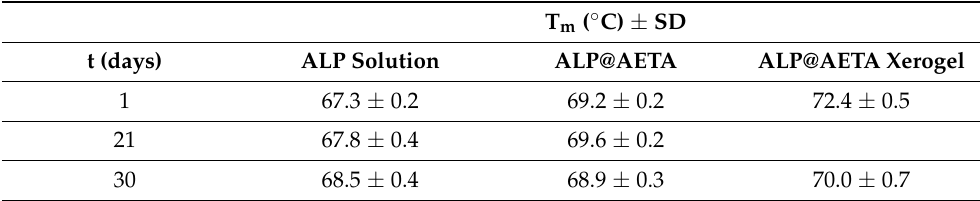
Table 1. Denaturation temperatures (T m ) of free ALP and freshly prepared ALP@AETA hydrogels as a function of storage time at 4 ◦ C and at room temperature for ALP@AETA xerogel. Standard deviation was determined from three